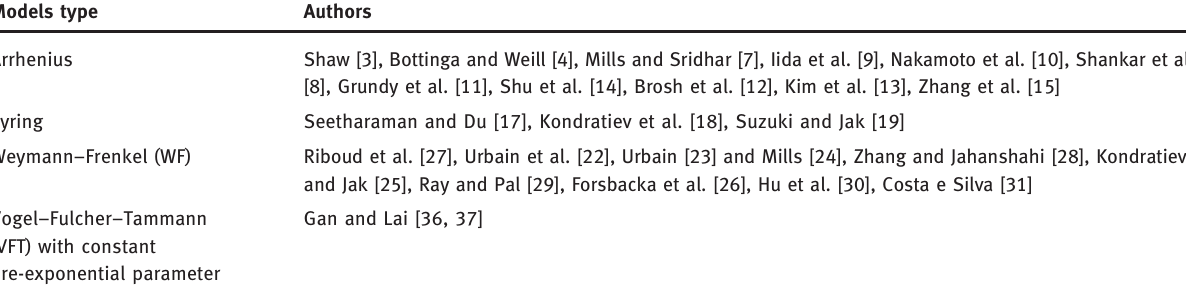
Table 1: Viscosity models for molten